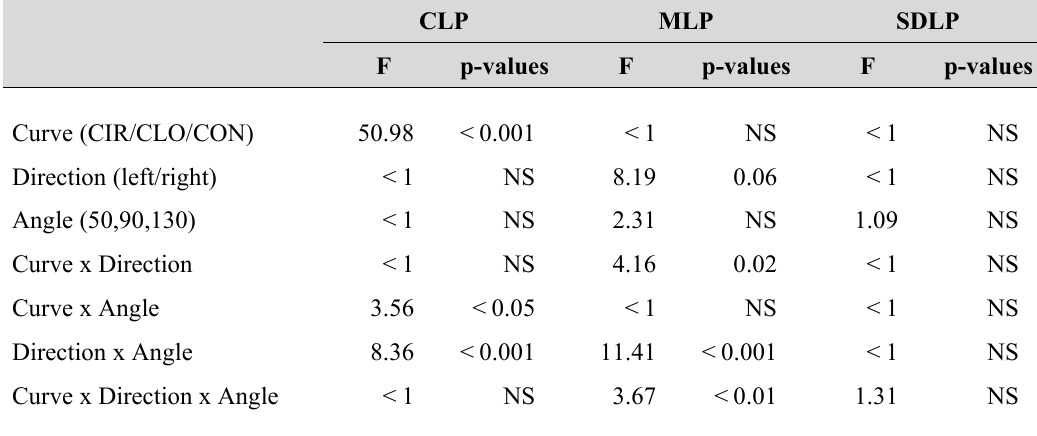
Table 4 Repeated-Measures ANOVA results, main effects of curve type (CIR/CLO/CON), direc- tion (left/right), and Angle (50° / 90° / 130°)